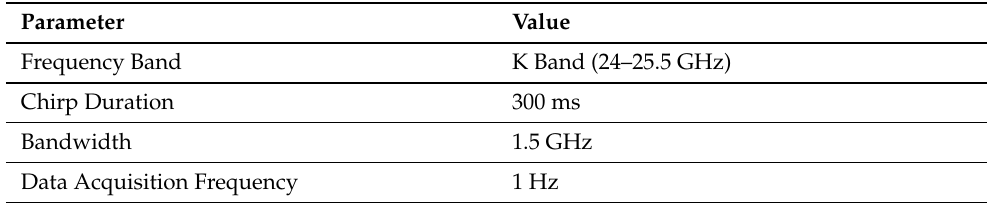
Table 2. FMCW parameters used during the